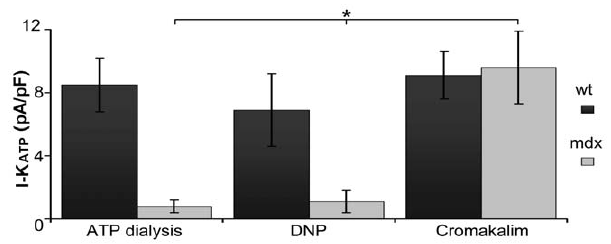
Figure 3. Summary of I ATP density measured at + 40 mV. Induction of the I ATP currents by: dialysis of intracellular ATP (n=8); mitochondria poisoning with DNP (n=12); or application of the selective agonist Cromakalim (n=9). Only in the latter case do mdx cardiomyocytes show an I ATP density similar to wt. I ATP in mdx cardiomyocytes is significantly different (* p , 0.05) than that induced by ATP dialysis or DNP treatment.